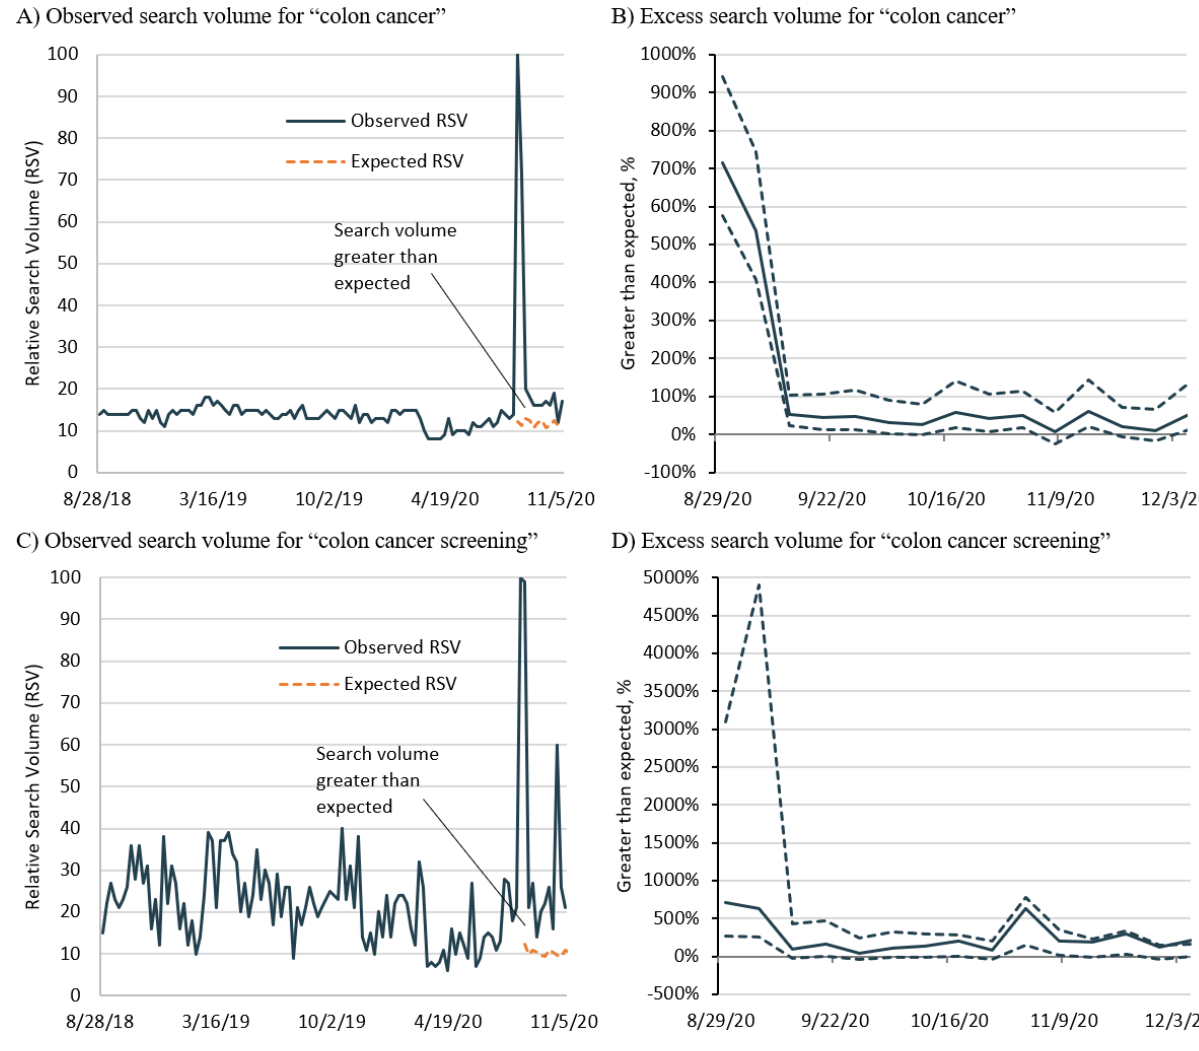
Figure 1. Greater than expected relative search volumes for colon cancer following Chadwick Boseman’s death. RSV: relative search